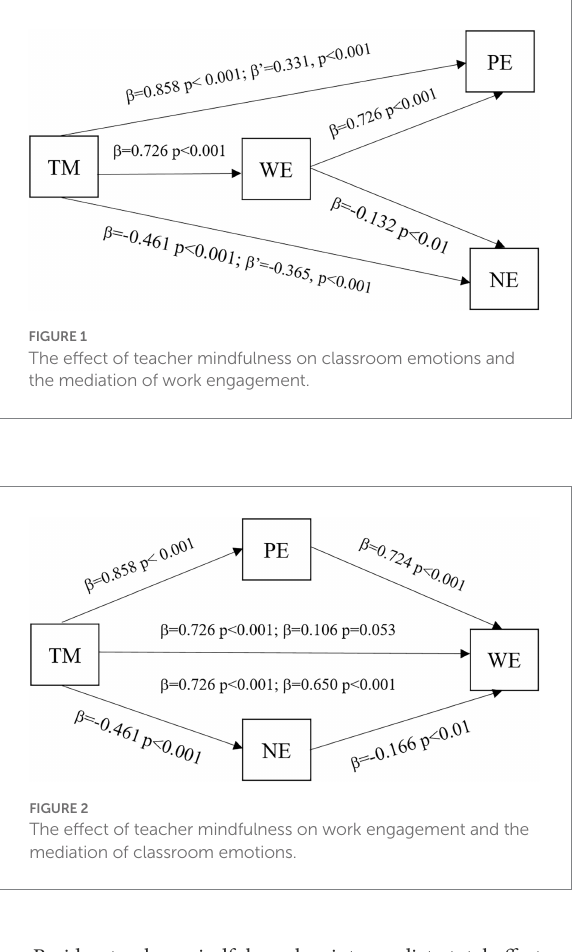
TABLE 2 Description and correlation.